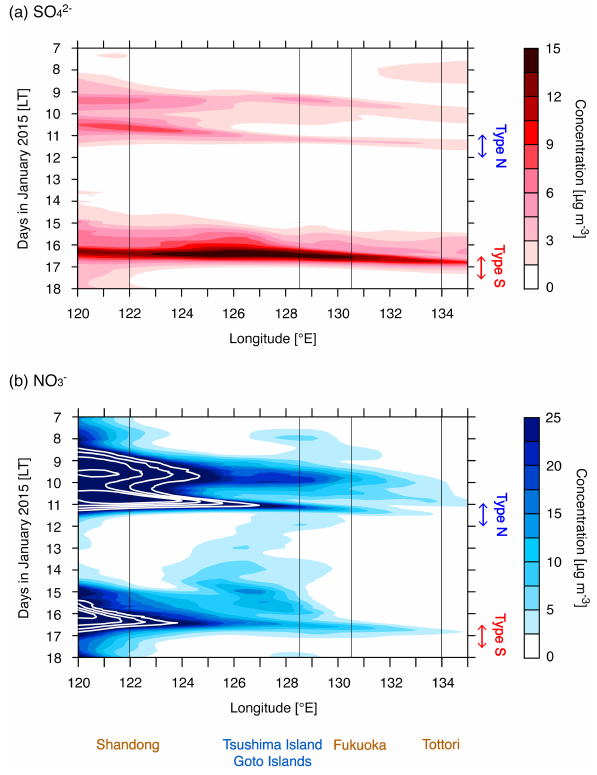
Figure 14. The outflow frequency of (a) SO 2 − contours shown by the white lines for NO − and 60µgm − 3 . The model results are averaged over 32–36 ◦ N and are shown as a time–longitude cross section. The longitudes of the representative locations are indicated by the thin black lines, and the location names are written in brown and blue at the bottom of the